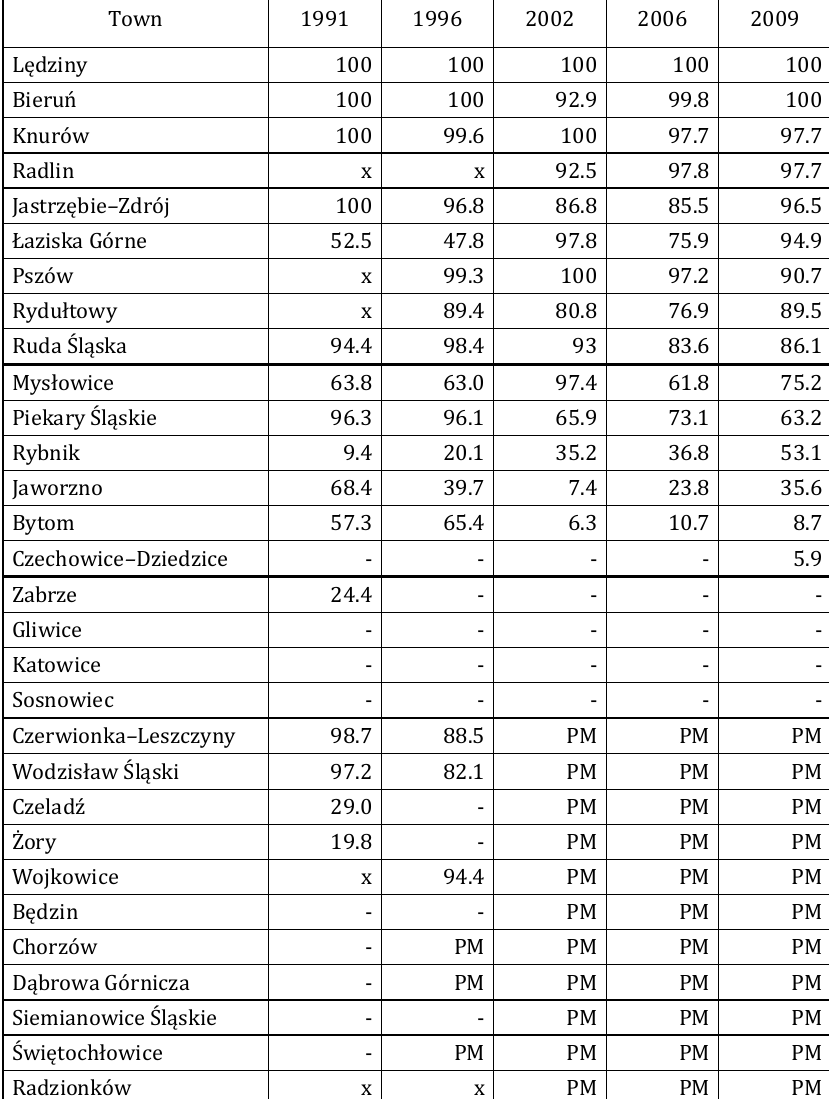
Table 5. Percentage share of section C – mining in the exogenous function (in terms of group) of towns in the Silesian voivodeship (author’s